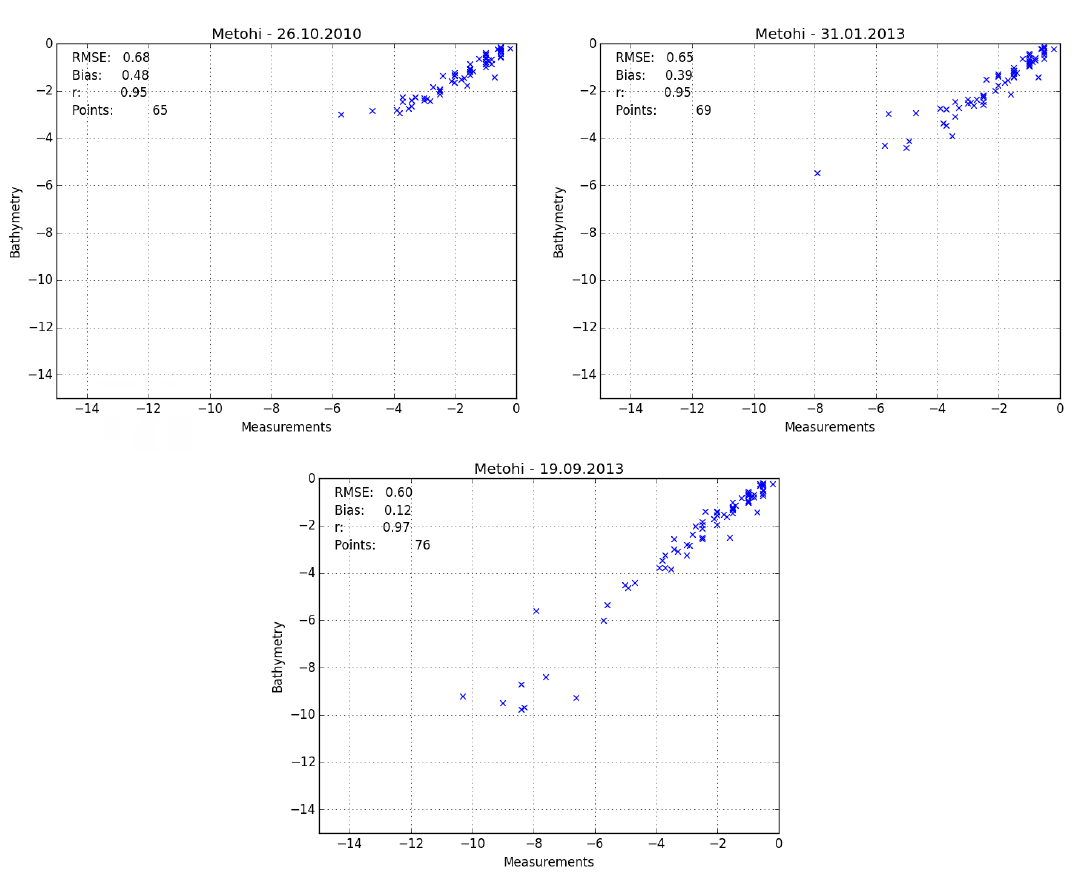
Figure 4: Comparison between field-measured bathymetry (x-axis) and satellite bathymetry (y-axis) at the Metohi peninsula site on three study